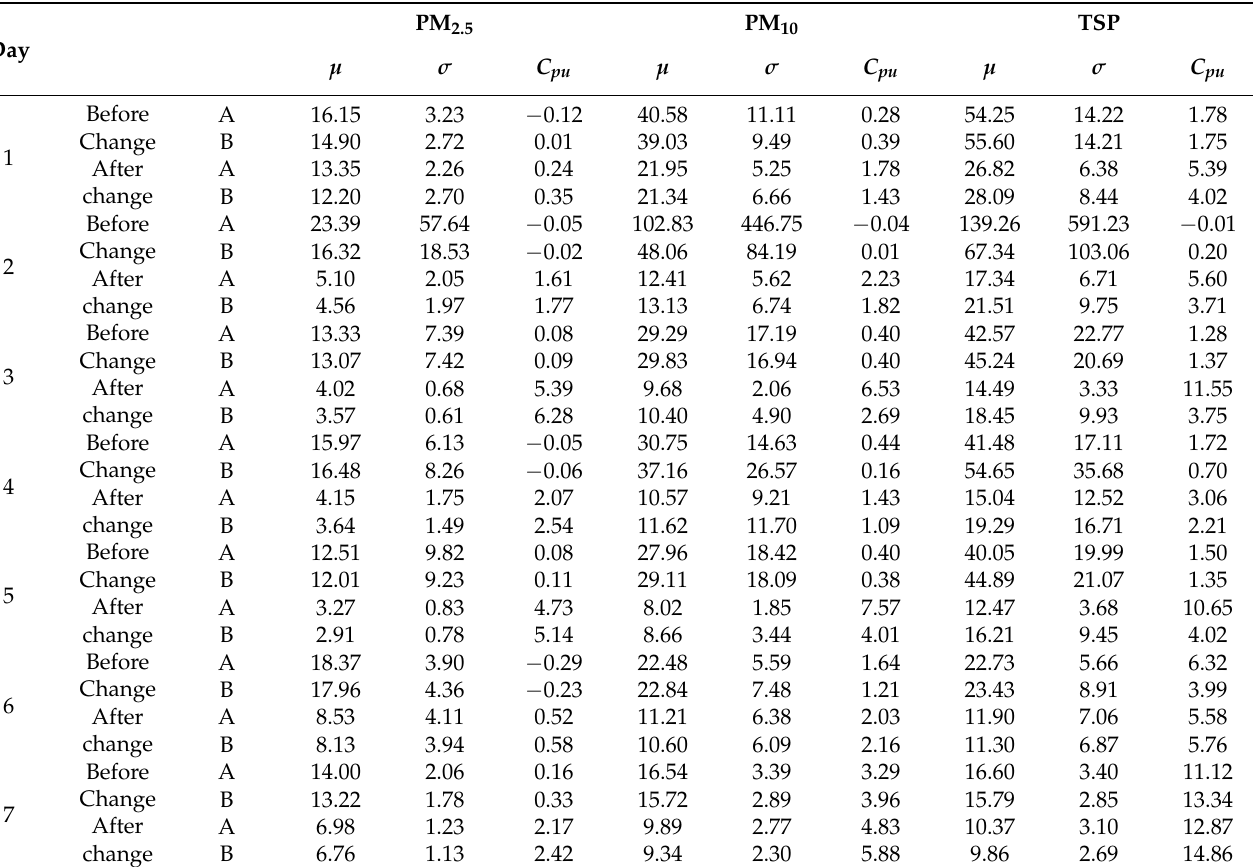
Table 3. Comparison of the indoor air quality indicators before and after the implementation of the improvement